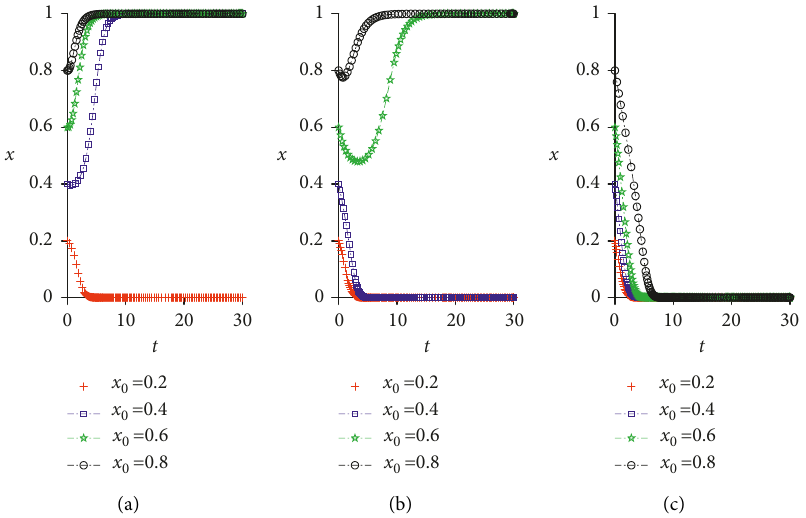
Figure 12: Impact of C on system evolution. Comparing (a), (b), and (c), as C cooperation strategy) decreases, the probability of the system evolving to the ideal state increases. (a) ′